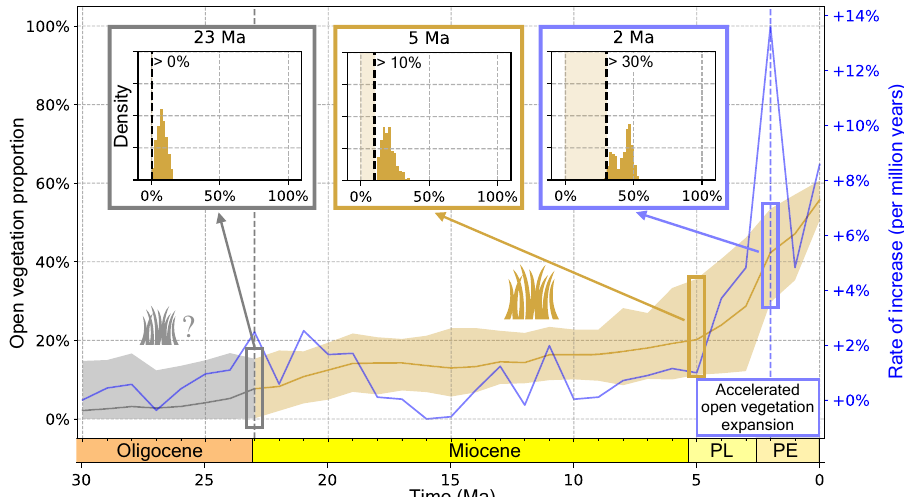
Fig. 4 | Predicted fraction of open vegetation through time. Fractions are cal- culated as the proportion of all terrestrial cells across North America predicted as open vegetation with the best model (model 1). The solid yellow line shows the mean estimates across all posterior samples, while the shaded area shows the 95% highestposteriordensity(HPD)interval.Thebluelineshowsthemeanrateofopen habitat expansion, calculated across each preceding 1-million-year time bin. The colored bar forming the x-axis marks the geological epochs covered by our pre- dictions,includingthePleistocene(PE),Pliocene(PL),Miocene,andOligocene(not